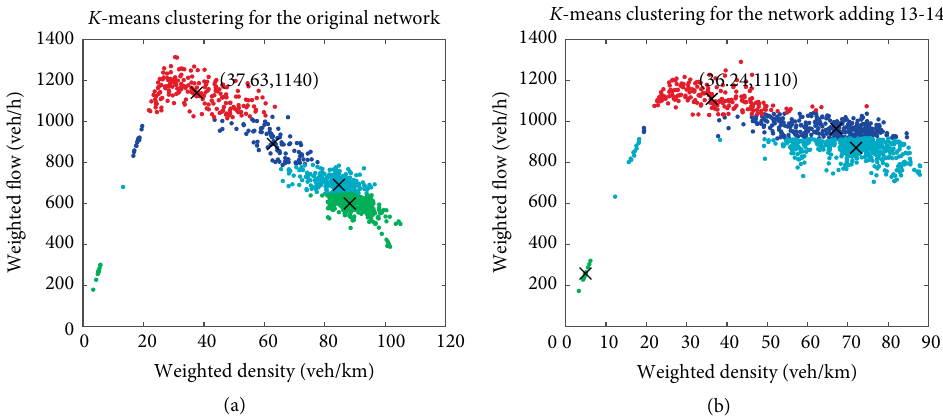
Figure 8: MFD comparison of two extended networks: (a) original network; (b) adding link pair (13-14).